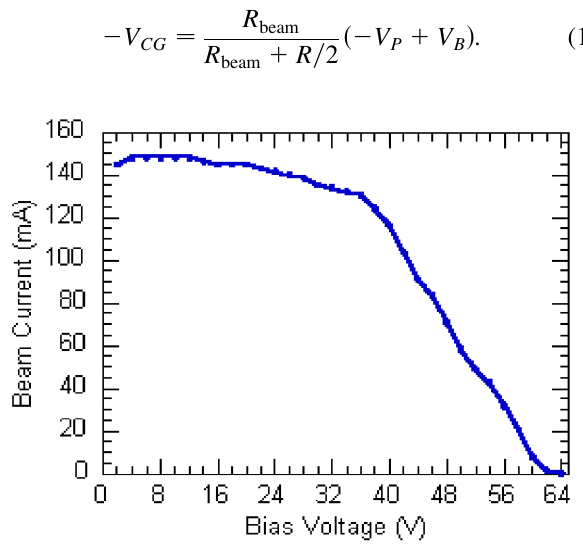
FIG. 13. (Color) Beam current between grid and anode versus bias voltage of the electron